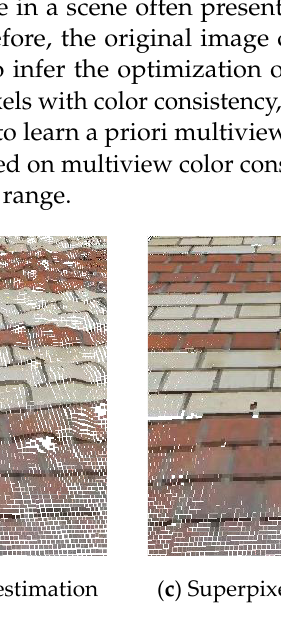
Figure 1. Superpixel information propagation.